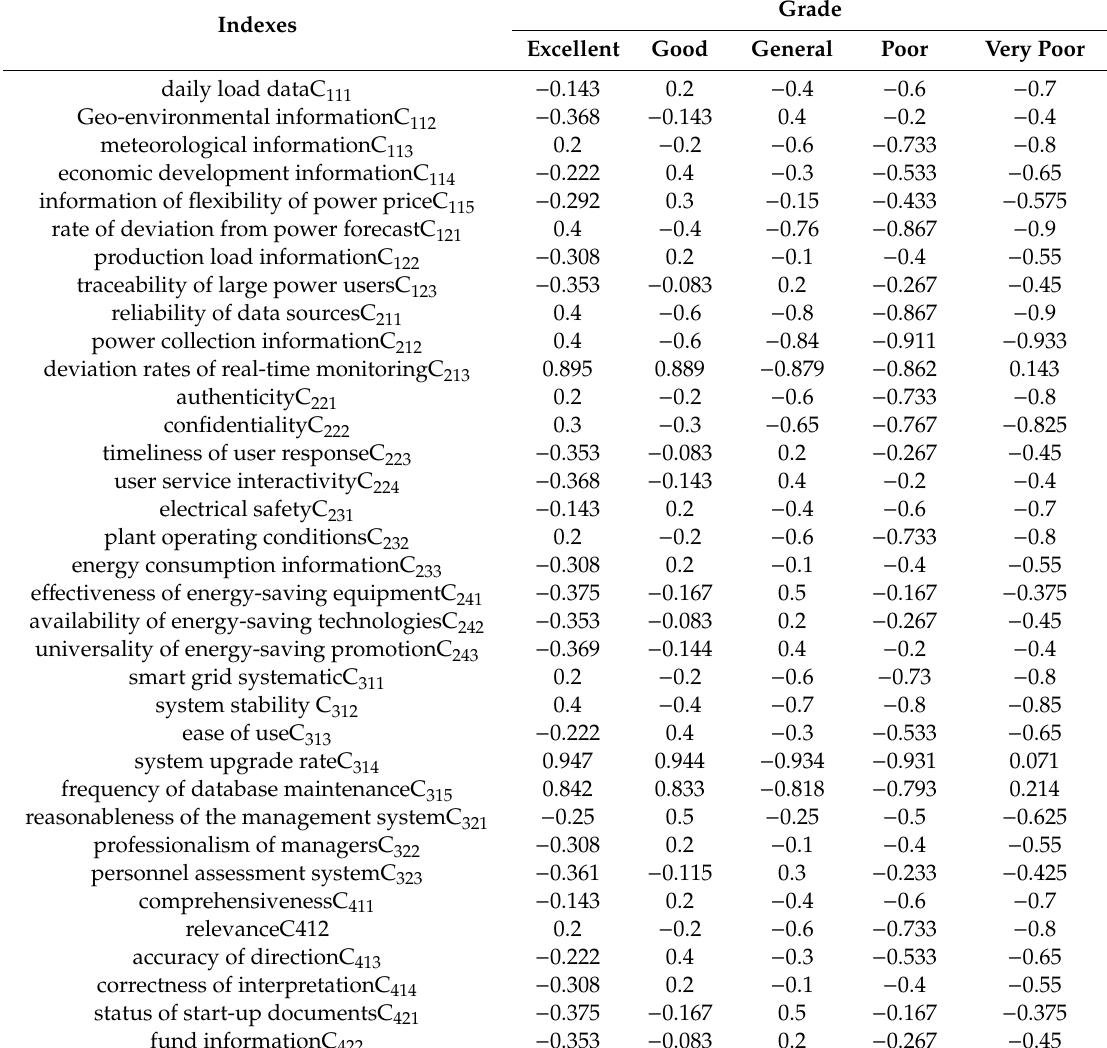
Table 8. Correlation function value of information quality level on the power demand